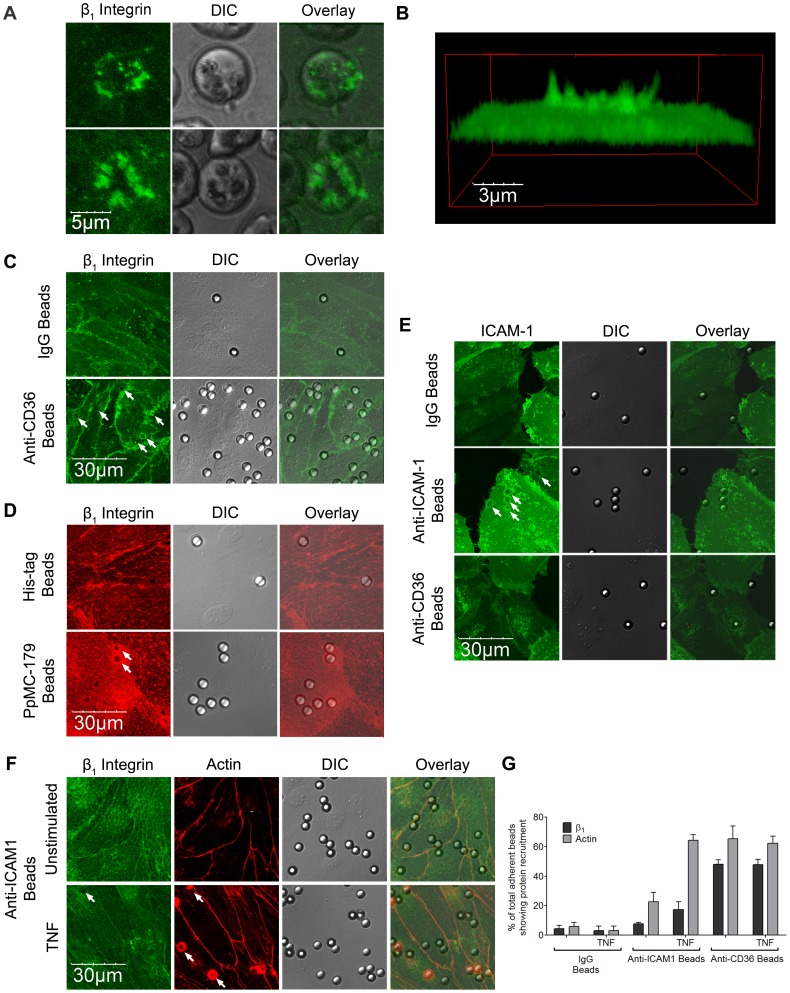
β1 integrin recruitment by adherent IRBC, antibody- or PpMC-179 coated-beads.HDMEC were grown to 95% confluence in ibidi VI chambers. (A) IRBC purified on a MACS separation column were added to a monolayer at 0.1% hematocrit. An FITC-labelled anti-b1integrin mAb was added at 10 µg/ml. The IRBC interaction with HDMEC was imaged in a humidified chamber with 5% CO2 at 37°C. Results are representative of 2 experiments. (B) 3D reconstruction of the cup-shaped structure formed by clustered β1 integrin on the endothelial cell membrane. (C and D) HDMEC monolayers in ibidi VI chambers were incubated with beads coated with IgG1, anti-CD36, anti-HIS or PpMC-179, the CD36 binding peptide of PfEMP1, for 30 min at 37°C in 5% CO2. The monolayers were washed 2× with HBSS to remove unbound beads prior to fixing with 1% PFA for 30 minutes at room temperature. Fixed cells were stained with an anti-β1 mAb at 10 µg/ml followed by Alexa 488-labelled anti-mouse IgG1 (C) or with a PE-labelled anti-β1 integrin mAb at 10 mg/ml (D). Results shown are representative of 3 experiments. (E) HDMEC monolayers in ibidi chambers transduced with GFP-ICAM-1 were incubated with beads coated with IgG1, anti-ICAM-1 and anti-CD36, and processed as in (C) and (D). (F) Unstimulated and TNF-α-stimulated HDMEC monolayers in ibidi chambers were incubated with beads coated with IgG1, anti-ICAM-1 and anti-CD36, and processed as in (C) and (D). The actin cytoskeleton was visualized by permeabilizing the cells for 5 min with 0.2% TX-100 prior to adding 1 µl of rhodamine-phalloidin in 60 µl HBSS to each chamber for 30 min at room temperature. Results shown are for anti-ICAM-1 coated beads only, and are representative of 3 experiments. All images were taken on an Olympus IX81 inverted confocal microscope (Center Valley, Pa) with Fluorview 1000 acquisition software using a PlanAPO 60× N.A. 1.42 oil immersion objective. White arrows indicate representative sites of β1 integrin or ICAM-1 recruitment. (G) Quantification of microscopic changes seen in (F). For every condition in every experiment, three randomly selected microscopic fields at 60× magnification were selected. Each field with 15–25 adherent beads were scanned, and adherent beads associated with protein recruitment were scored as positive. Beads partially in the field of view or rings with no adherent beads were excluded in the enumeration. Results are expressed as positive adherent beads/total adherent beads ×100% (n = 3).